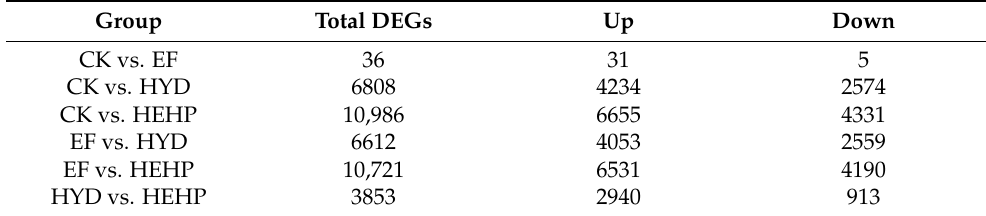
Table 2. Statistics of differentially expressed